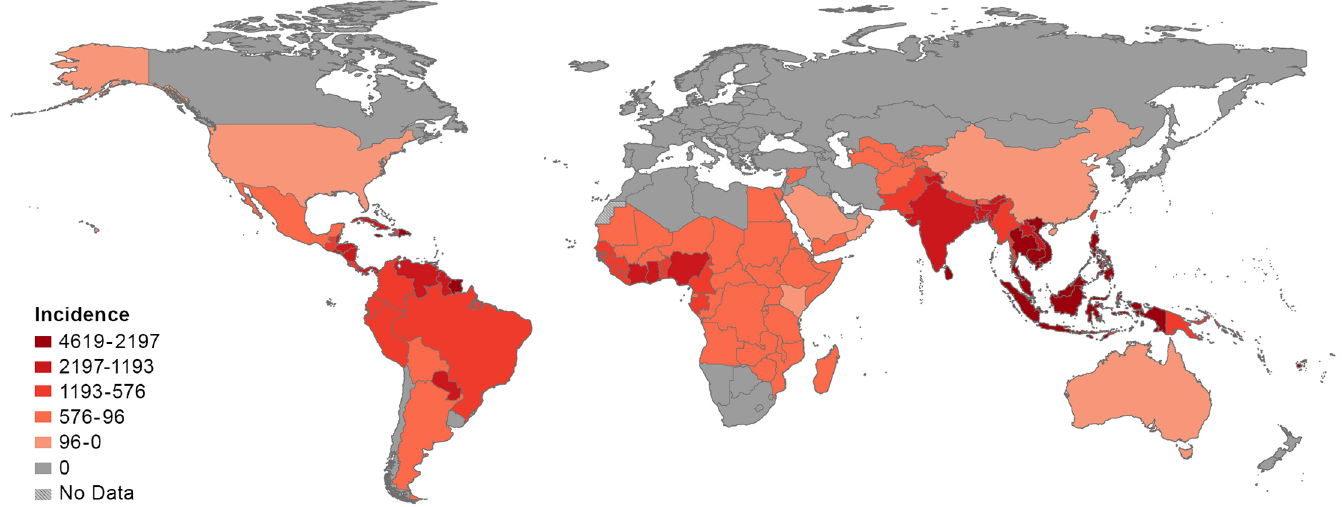
Fig 1. Global dengue incidence per 100,000person-years in 2013. Adapted from Stanaway et al. [40]. NOTE: No estimates are availablefor Western Sahara as it was not a modeledlocationin the Global Burden of Disease Study (GBD) 2013.